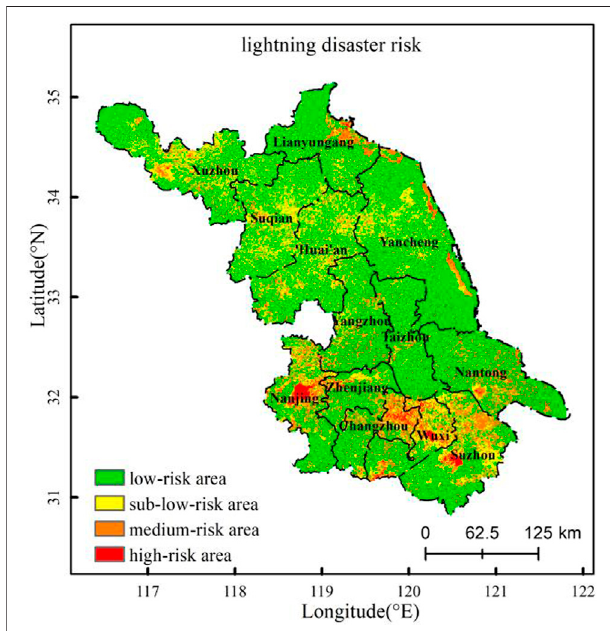
FIGURE 6 | Lightning disaster risk zoning in